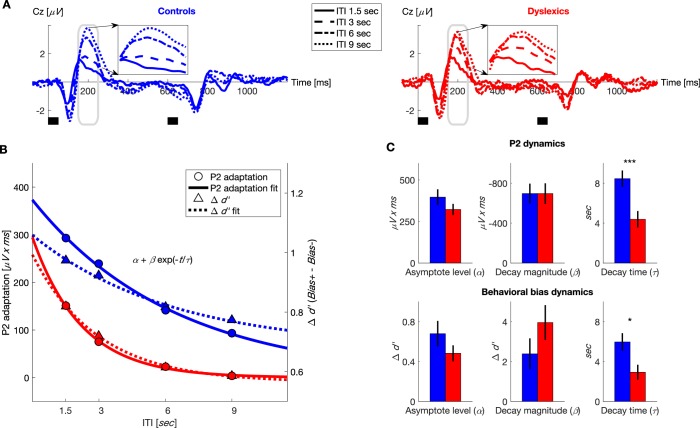
Dyslexics’ decay of both neural adaptation and behavioral contraction bias was faster than controls’.(A) Grand average ERPs, plotted separately for blocks with different ITIs, for controls (n = 23; blue, left) and dyslexics (n = 25; red, right). Timing of the two tones in each trial is denoted by the short black bars under the plots. Insets: P2 range (denoted in gray) enlarged. Dyslexics’ P2 area was similar for 6 and 9 s ITIs, whereas controls’ P2 was larger for the 9 s interval. (B) The decrease in P2 adaptation (solid lines, circles, left scale; estimated magnitude at asymptote minus fitted curve) and the decrease in contraction bias (dashed lines, triangles, right scale; reflecting implicit memory decay) as a function of ITI. Symbols denote groups’ means, and plotted curves were fitted to these means. (C) Groups’ means and SEMs of the individually fitted parameters (to an exponential decay) of both P2 adaptation (top) and behavioral contraction bias (bottom). In both, dyslexics differed from controls only in the estimated rate of decay (P2: p<0.0005; Δd': p<0.05).